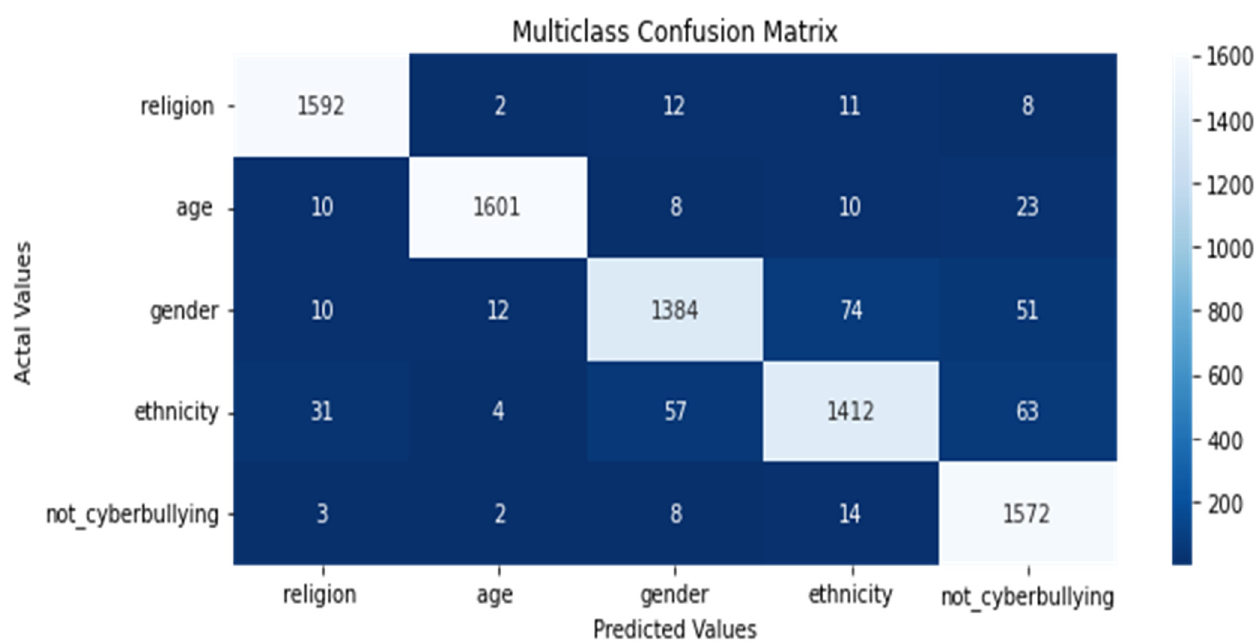
Figure 10. Confusion matrix of the CNN-BiLSTM model using the multiclass classification dataset.